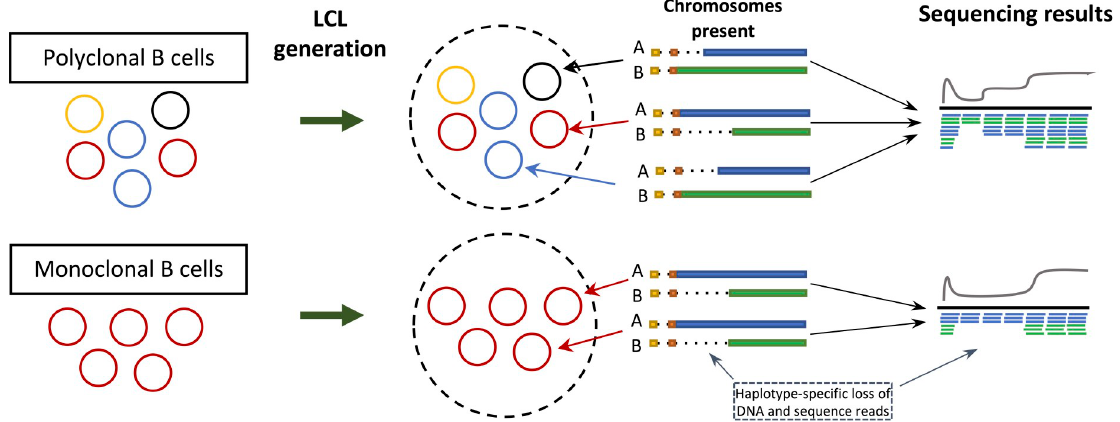
Fig 1. Generation of LCLs can lead to loss of sequencing data. LCLs are generated from a pool of B cells. A pool of polyclonal B cells will contain different V(D)J recombination events, mitigating the impacts of V(D)J associated deletions on generated sequencing data. In such cases, we would expect read coverage from both chromosomes across the IGH locus. In contrast, LCLs representing monoclonal B cells ( i . e . B cells in which the same V, D, and J genes are selected by V(D)J recombination), would result in the loss of haplotype-specific sequencing